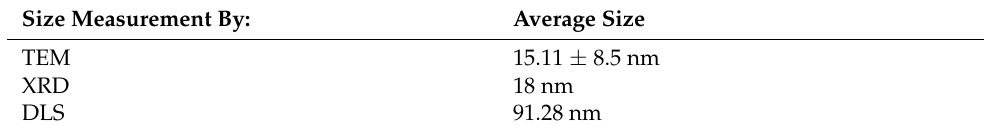
Table 1. The average size of green synthesized AuNPs calculated by TEM, XRD, and DLS. Size Measurement